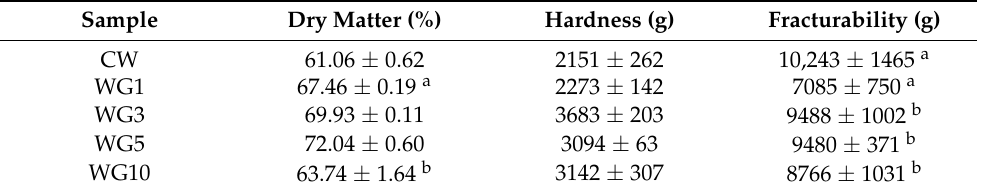
Table 1. Dry Matter, Hardness and Fracturability in Control Samples and in Samples with Added Grape